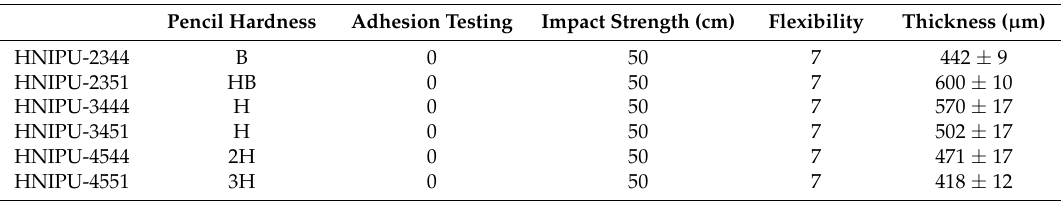
Table 4. Mechanical properties of different HNIPU